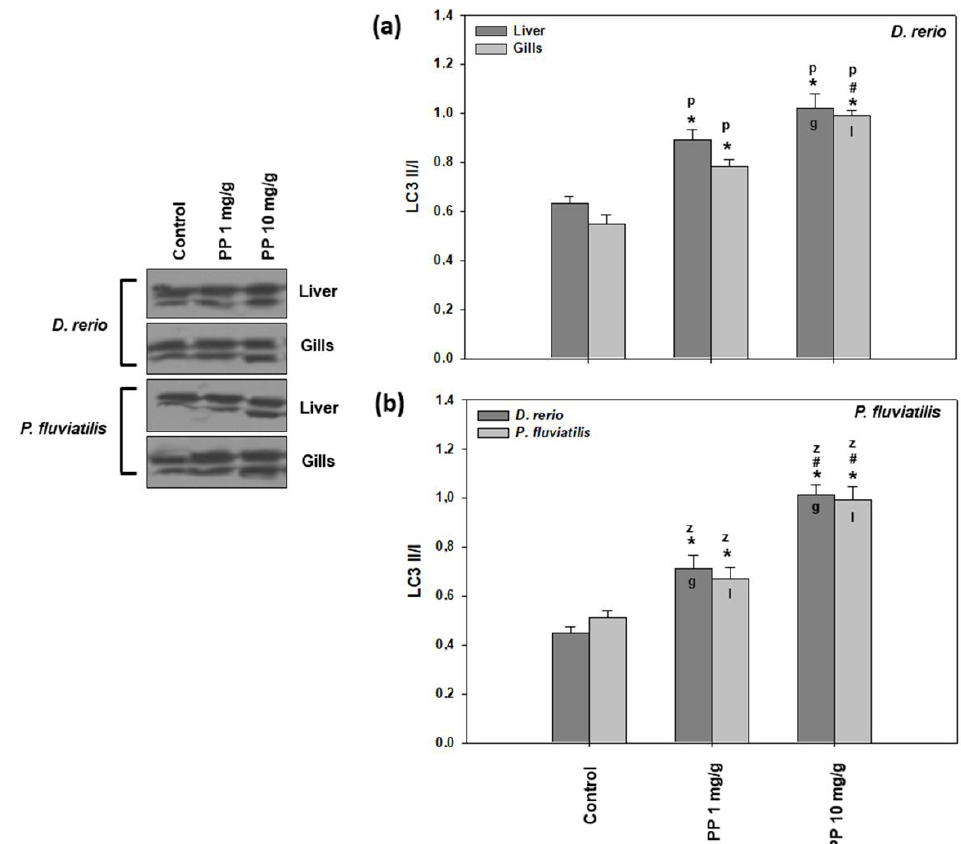
Figure 4. LC3 II/I levels (mean ± SD) in the liver and gills of the Danio rerio ( a ) and Perca fluviatilis ( b ) control and dietary exposed to 1 mg PP-MPs/g and 10 mg PP-MPs/g dry food. Asterisk (*) denotes significant differences ( p < 0.05) compared to the control group, dash (#) denotes significant differences ( p < 0.05) between the two examined concentrations: 1 mg PP-MPs/g and 10 mg PP-MPs/g, lower case letters “z” and “p” denote significant differences ( p < 0.05) between the two examined species D. rerio and P. fluviatilis , respectively, while lower case letters “g” and “l” denote within species significant differences ( p < 0.05) between the gills and liver, respectively.